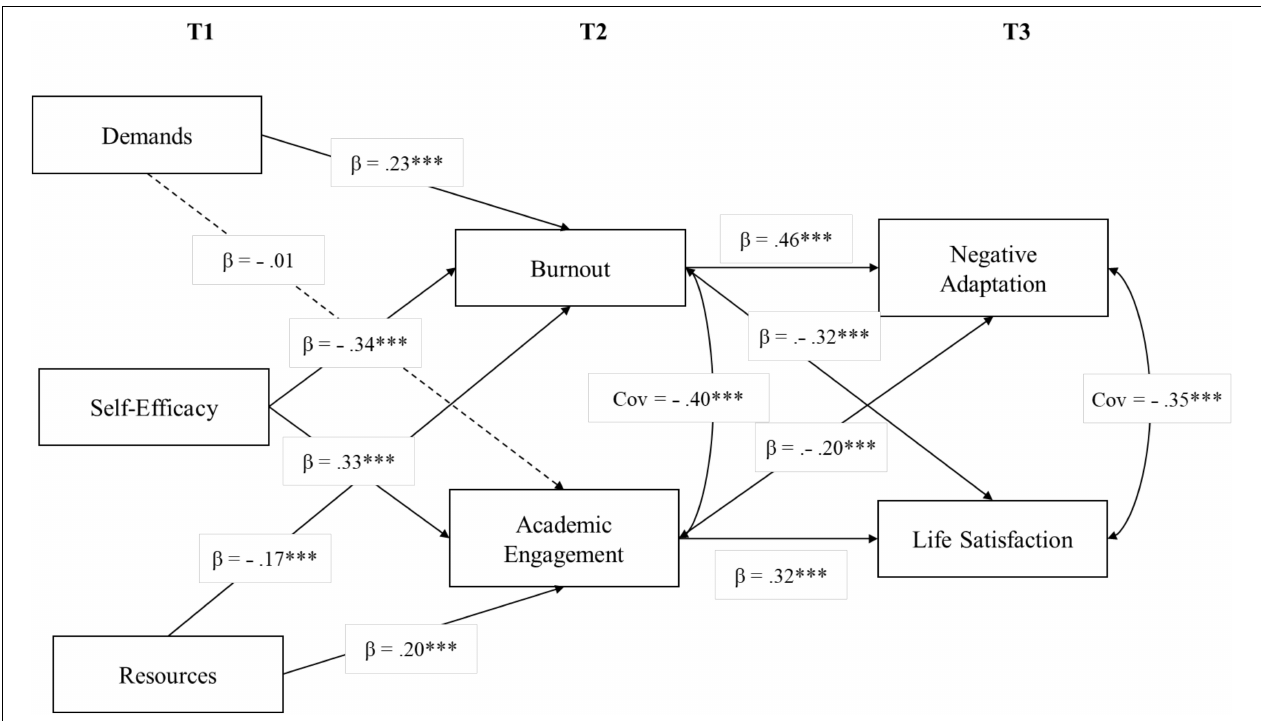
FIGURE 2 | Analysis of predictive paths between variables of interest. *** p <